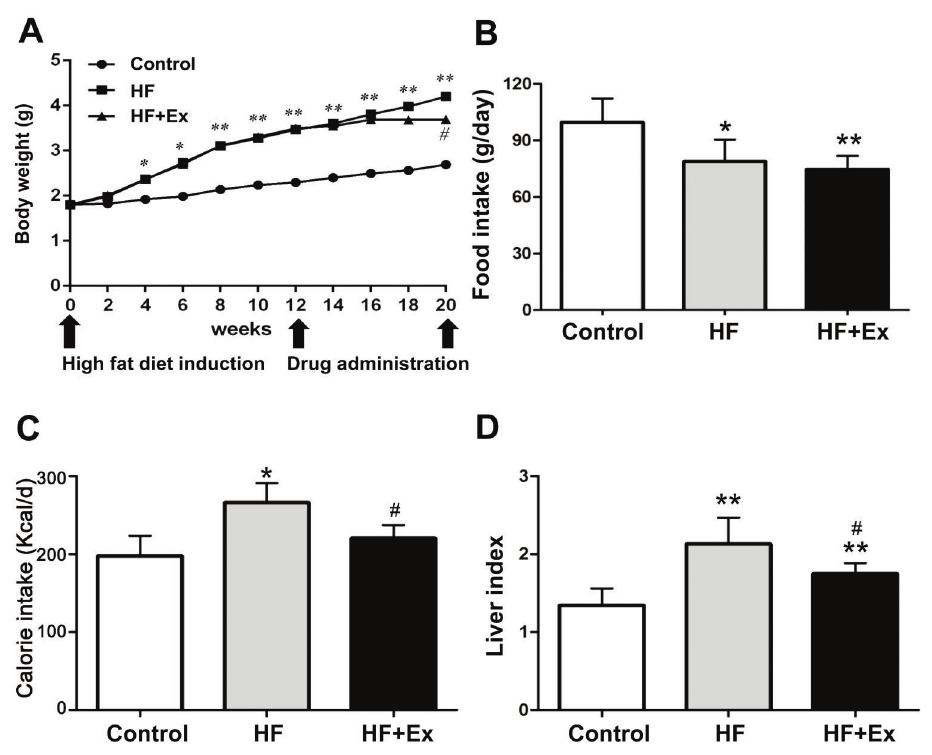
Figure 1. Changes in body weight, food intake, and liver index in exenatide (Ex)-treated high fat (HF)-induced obese rabbits (n=8). A , Body weight during HF diet feeding detected every 2 weeks. B , Average food intake during HF diet feeding. C , Average energy intake during the experimental period. D , Upon sacri fi ce at the end of 20 weeks, the liver index, which is equal to the liver weight/body weight x 100, was calculated. Data are reported as means ± SD. *P o 0.05, **P o 0.01 compared with the control group; # P o 0.05 compared with the HF group